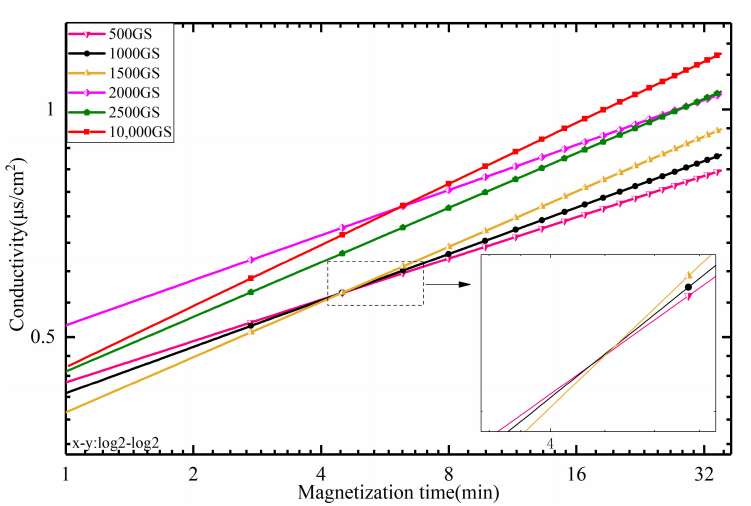
Figure 7. Fitting curve of conductivity of distilled water with magnetization time under different magnetic fields.